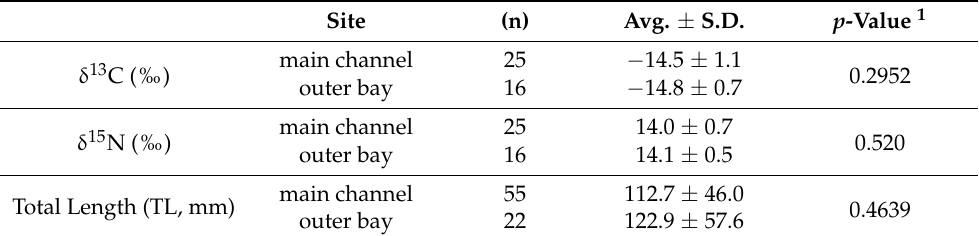
Table 1. Spatial variation in carbon and nitrogen isotope ratios in P. argentata sampled at Gwangyang Bay. Main channel (St. 1, St. 2, St. 3 in Figure 1) and outer bay (St. 4) were separated by physical and chemical properties, as documented by Kim et al. (2019).